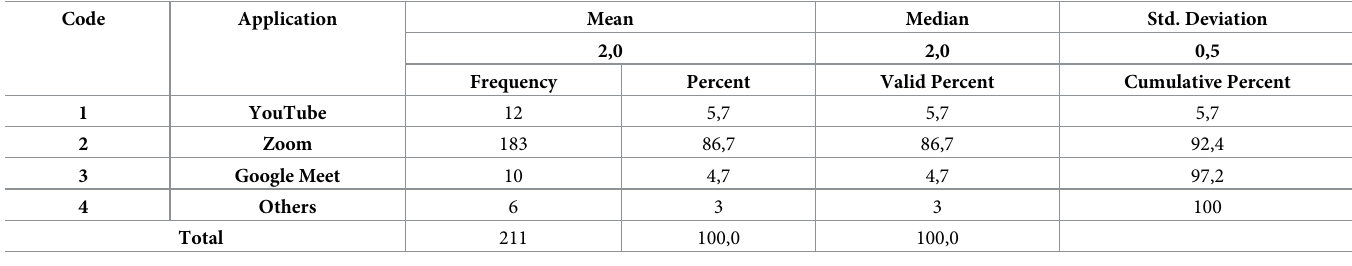
Table 6. Applications